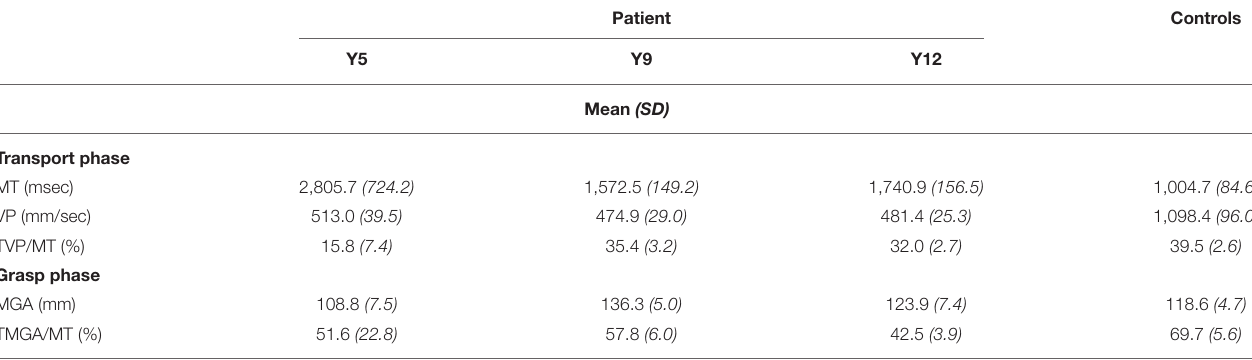
TABLE 2 | Kinematic parameters of the reach-to-grasp movement for the paretic upper limb of the patient and for the right upper limb of 6 control subjects.